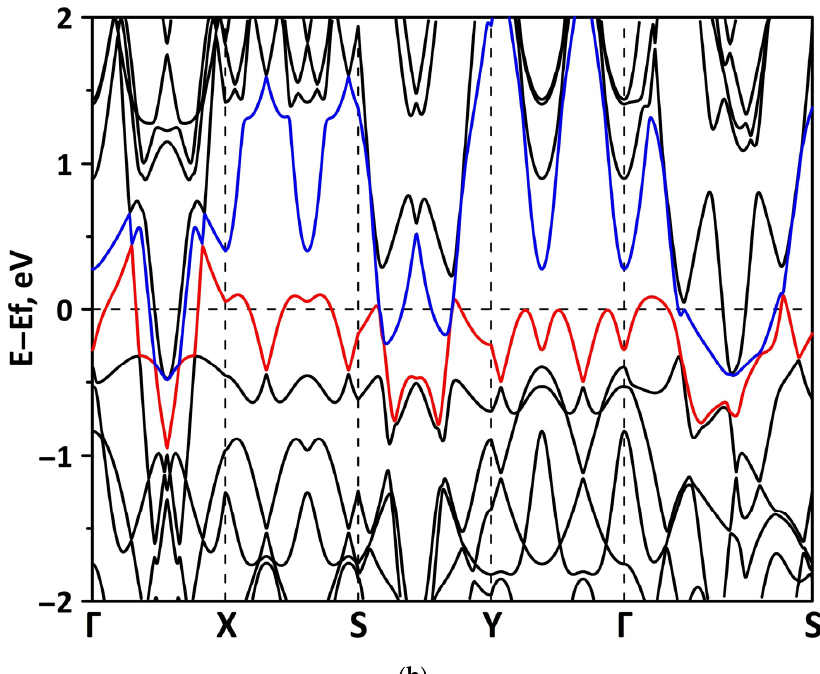
Figure 21. Fragments of the band diagrams near the Fermi level (shifted to 0 eV) of borophene/GaN heterostructure under biaxial stretching by 2% ( a ) and 6% ( b ). The VBM is highlighted in red and the CBM is highlighted in blue.